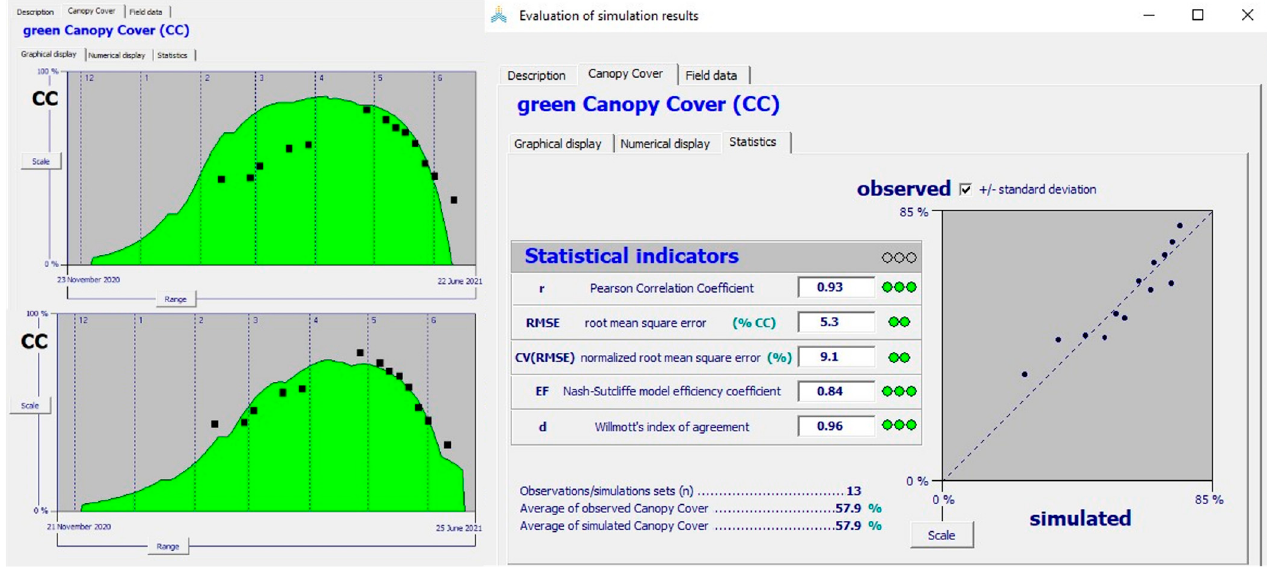
Figure 4. Statistical panel of AquaCrop Model for CGC and CDC calibration. Table 2. Calibrated conservative parameters of AquaCrop used in simulation.